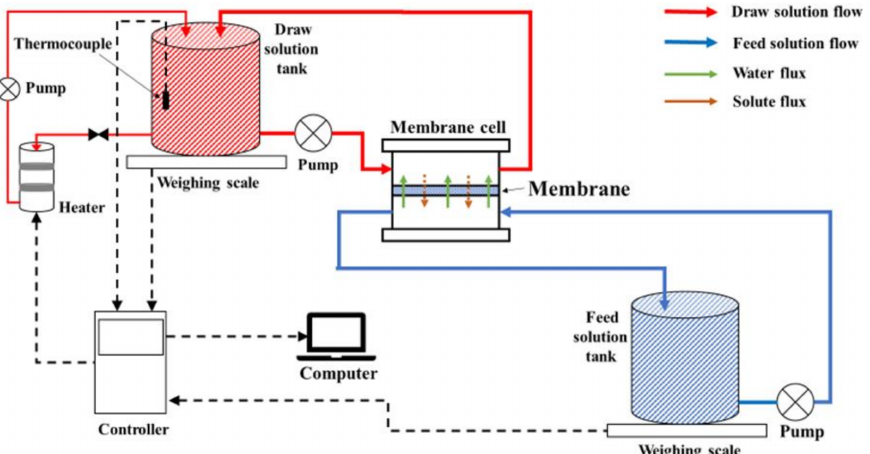
Figure 2. FO bench-scale flat-sheet